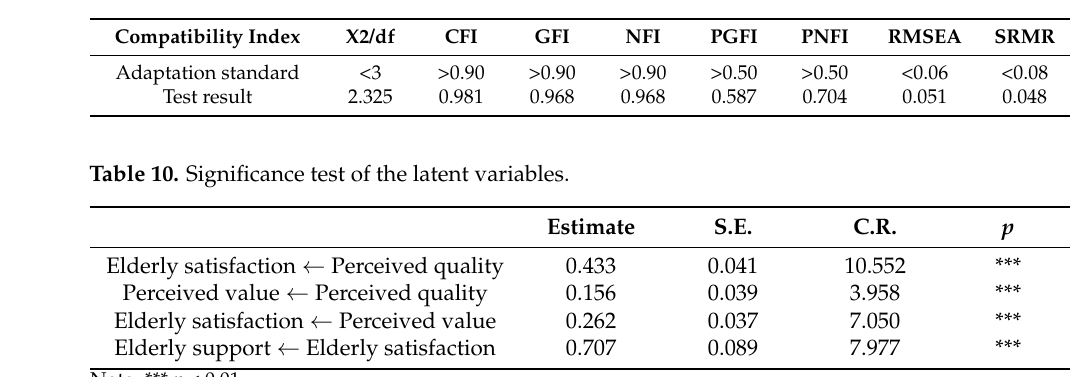
Table 9. Modified model fit test.